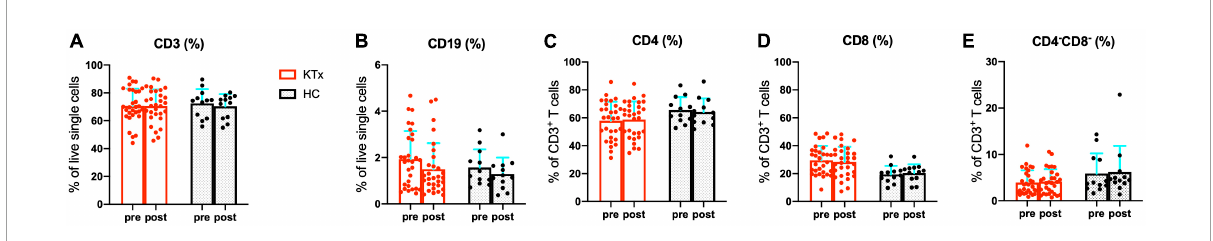
FIGURE2 Quantification of major immune lymphocyte subsets among PBMCs. Comparison of the proportions of CD3 + T cells (A) , CD19 + B cells (B) , CD4 + T cells (C) , CD8 + T cells (D) , and CD4 - CD8 - T cells (E) in KTx recipients ( n = 30) and HCs ( n = 12) pre- and post-vaccination. Bar plots depict mean ± SD. Data were analyzed using the Mann-Whitney U test.